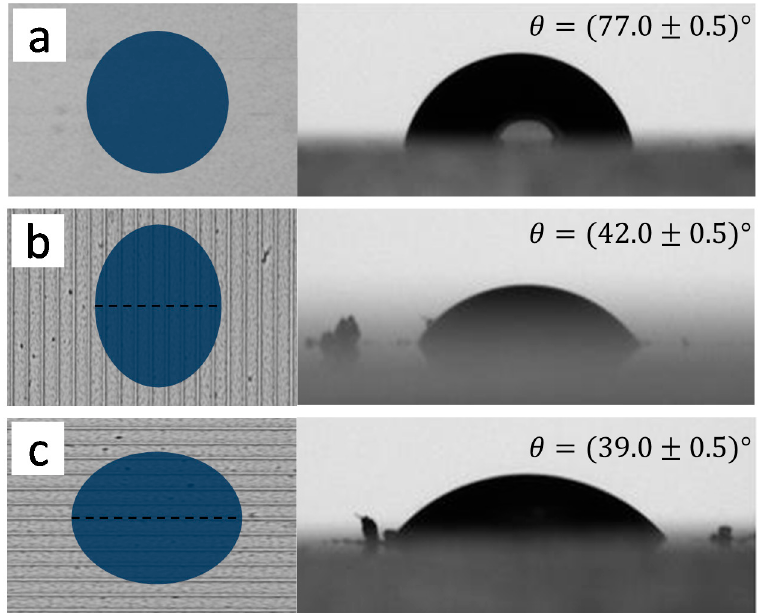
Figure 3. Water contact angle measured for: ( a ) reference sample ( θ = (77.0 ± 0.5)°); ( b ) perpendicular to the microstrucutred lines ( θ = (42.0 ± 0.5)°); ( c ) parallel to the microstructured lines ( θ = (39.0 ± 0.5)°). The dashed lines represent the direction along which the contact angles were obtained. The left column is only an illustration of the contact angle anisotropy observed in the right column.